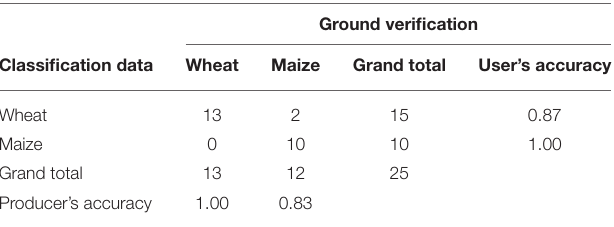
TABLE 3 | Raw tally confusion matrix of land cover and accuracies of the Sentinel-2 (December 30th 2016) classification.